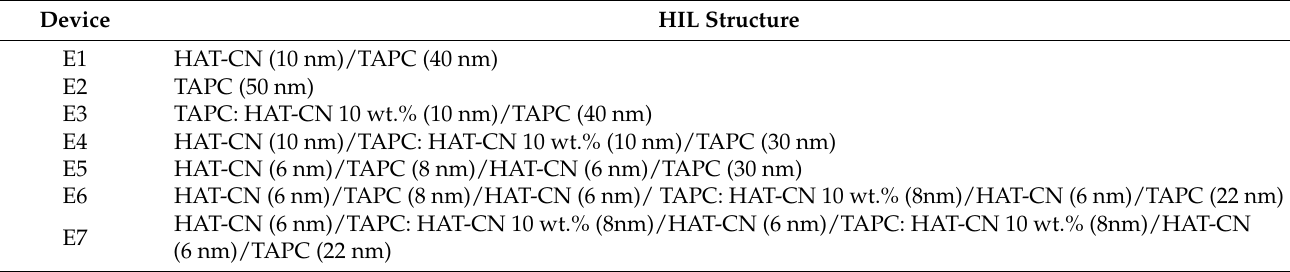
Table 2. Structures of the deep-red PhOLEDs with different HIL